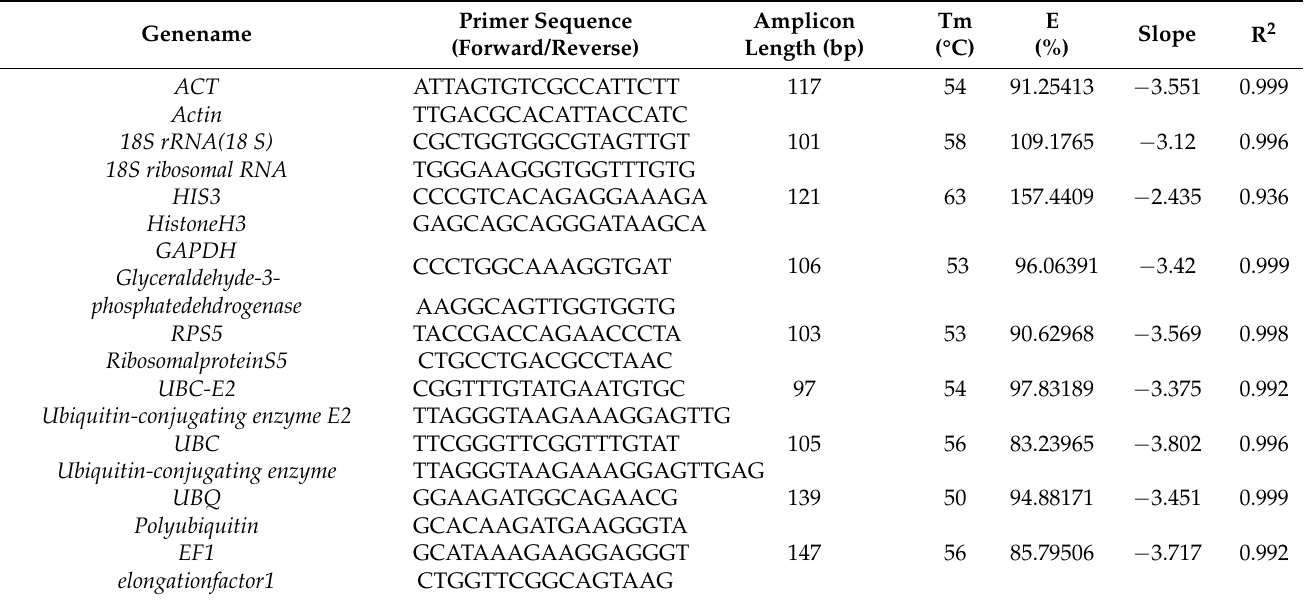
Table 1. Information on the candidate reference genes of